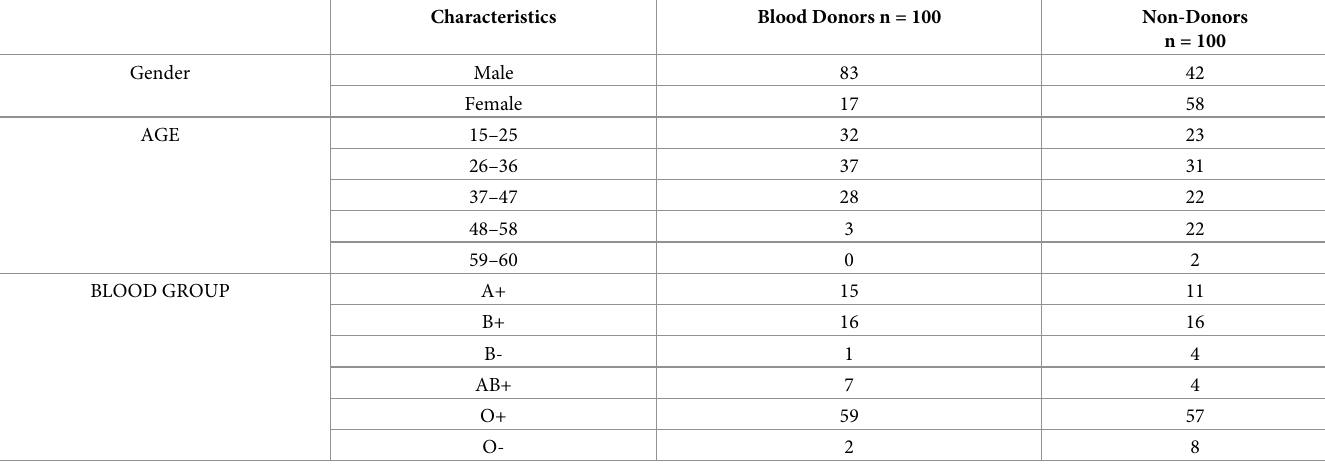
Table 1. Demographic characteristics of study